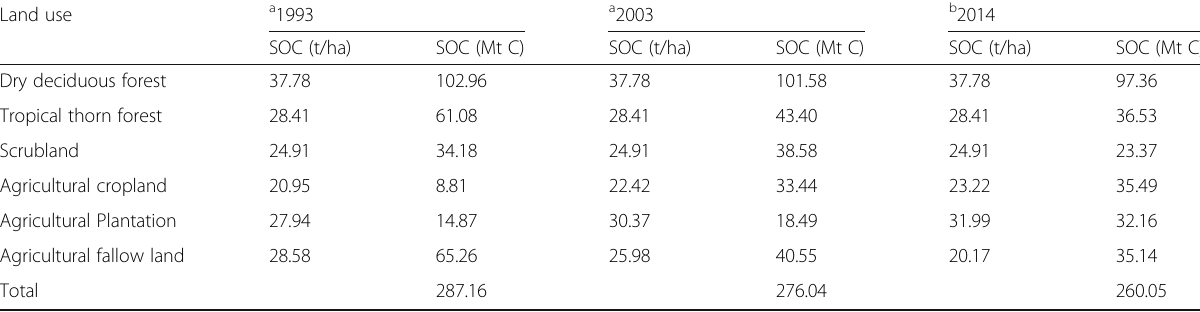
Table 9 Net change in SOC pool within 21 years from 1993 to 2014 Land